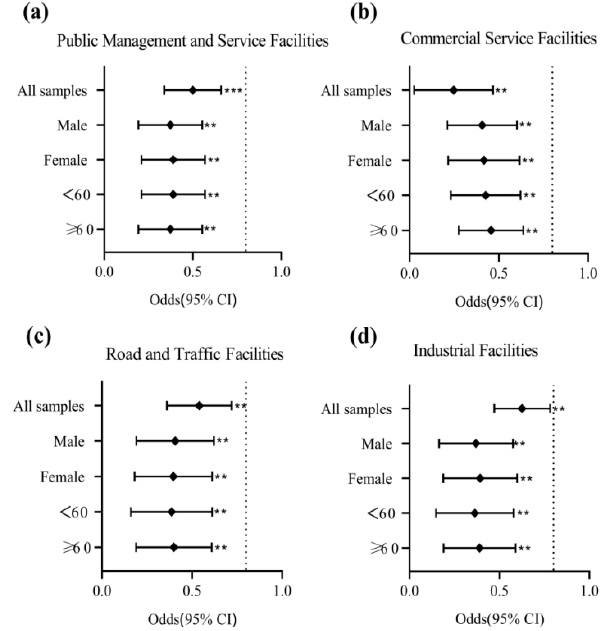
Figure 6. Results of MGSEM’s hierarchical analysis of the relationship between different types of built environments and hypertension. Note: ① ( a ): effects of public management and service facilities on hypertension in different characteristic groups; ( b ): effects of commercial service facilities on hypertension in different characteristic groups; ( c ): effects of road and traffic facilities on hypertension in different characteristic groups; ( d ): effects of industrial facilities on hypertension in different characteristic groups; ② Symbols denote probability, and bars denote 95% CI. Significance levels: * p < 0.05, ** p < 0.01 and *** p < 0.001.